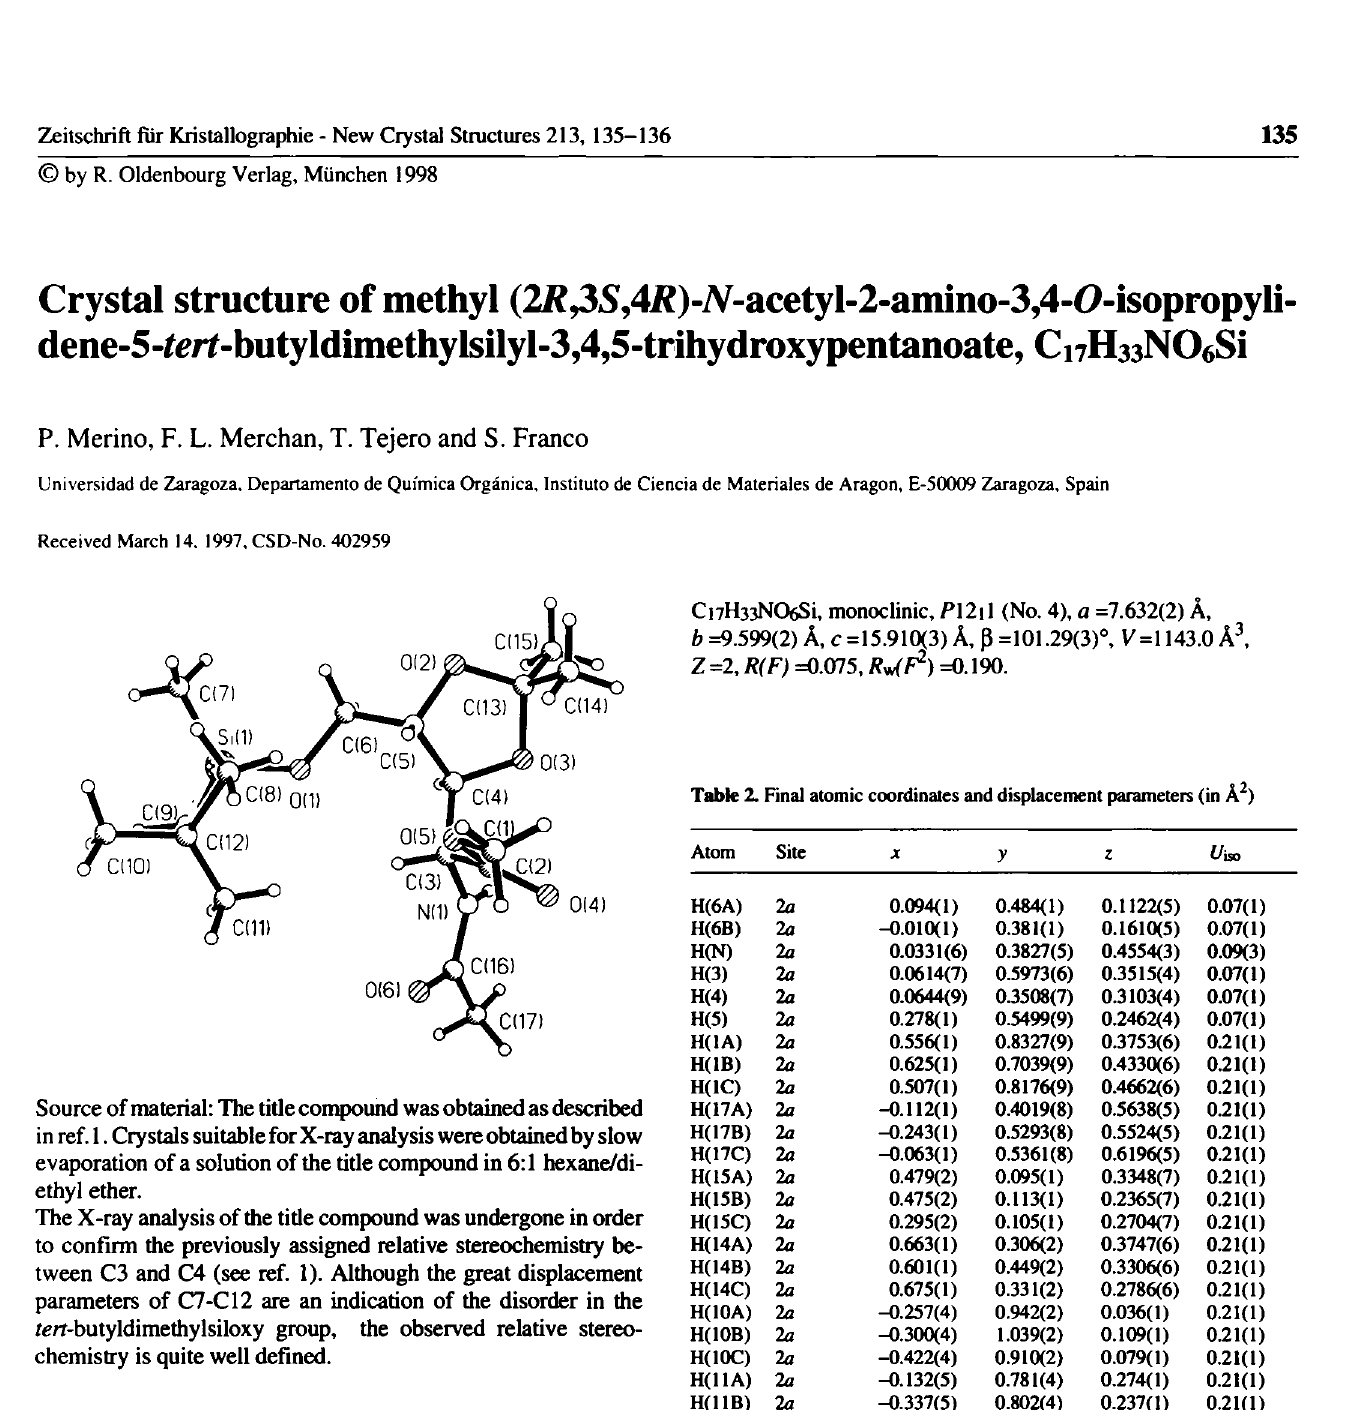
Table 1. Parameters used for the X-ray data collection Crystal: